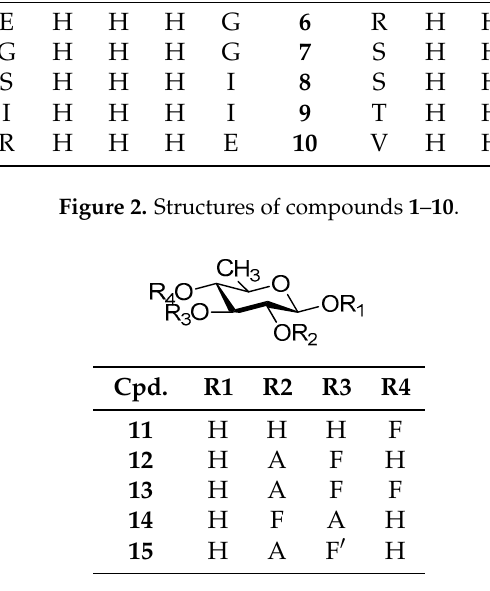
Figure 4. Structures of compounds 16 – 20 .